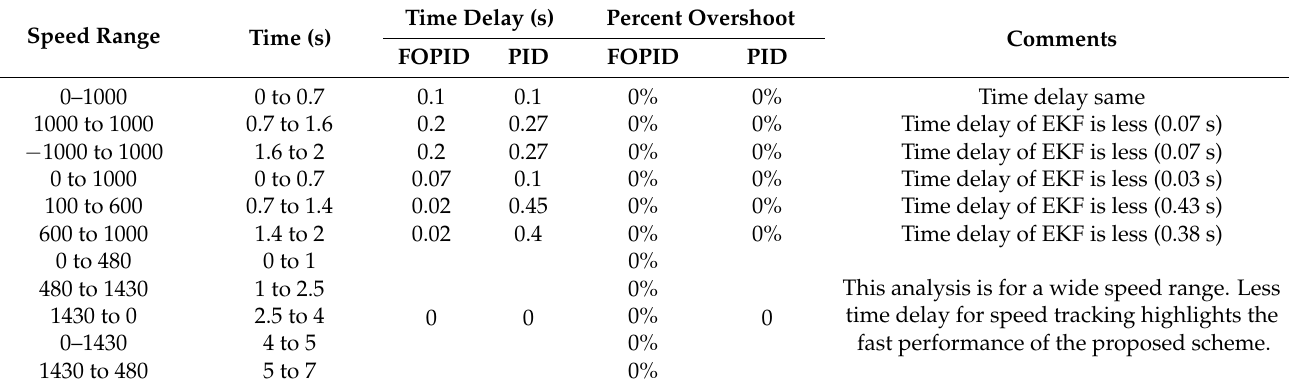
Table 4. Comparative analysis of speed and Tracking error.